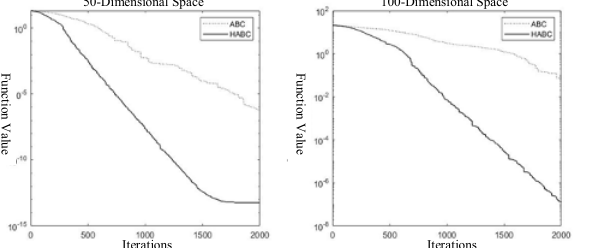
Fig. 3. The convergence curves of Griewank in 50-dimensional space and 100-dimensional space.